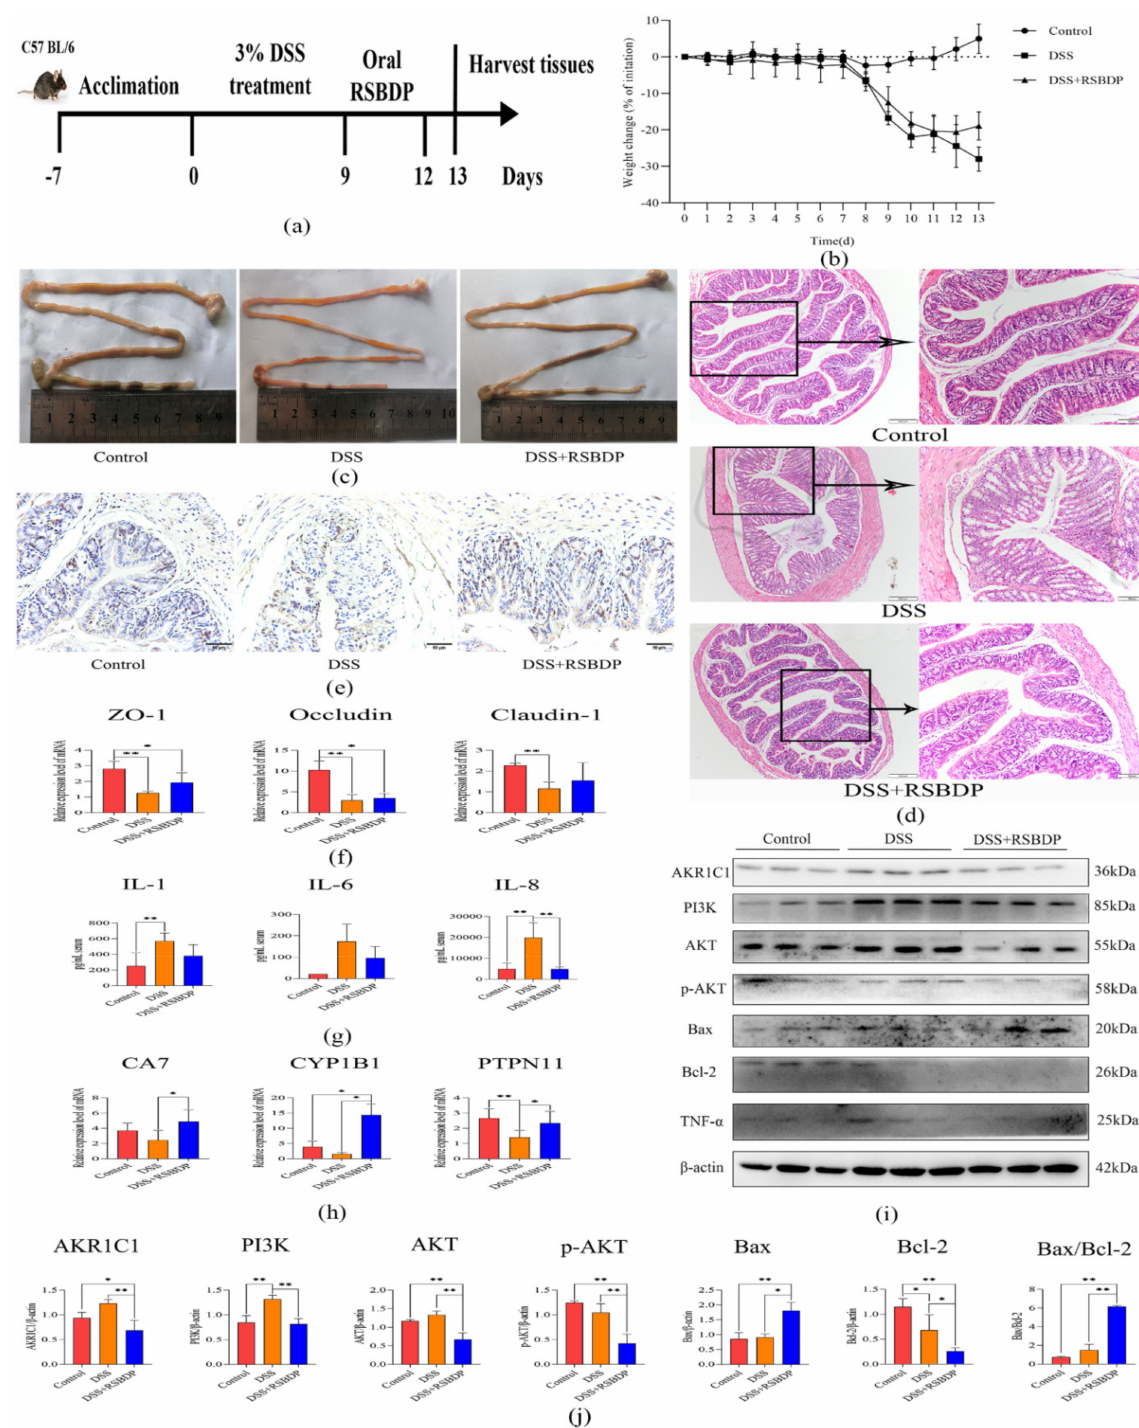
Figure 7. Experimental validation in DSS-induced colitis model. ( a ) An illustration of the mouse model of colitis used in this study. ( b ) Changes in body weight of mice after DSS and RSBDP treatment. ( c ) The intestines from control and IBD mice with RSBDP therapy. ( d ) H&E staining of the colon from control, DSS, and DSS + RSBDP groups. ( e ) The immunohistochemical results of the proliferation-associated maker gene Ki67. ( f ) qRT − PCR results of ZO − 1, Occludin, and Claudin − 1. ( g ) The concentrations of IL − 1, IL − 6, and IL − 8 in serum. ( h ) qRT − PCR detection of the partial targets in Tables 3 and 4. ( i ) Western blot analysis of AKR1C1, PI3K, AKT, p − AKT, Bax, Bcl − 2, and TNF − α . ( j ) The quantitative analysis of western blot. Data were shown as means ± SEM ( n = 3–5 per group). * p < 0.05, ** p <